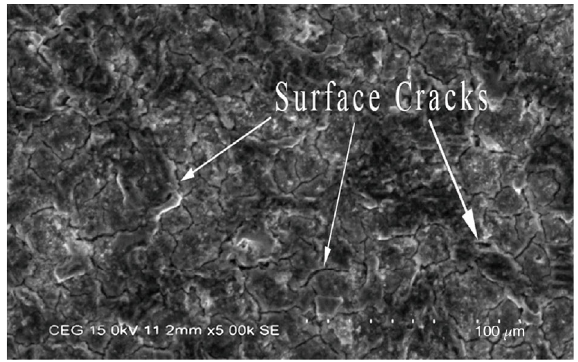
Figure 7: Surface microcracks of Al/GO composite.